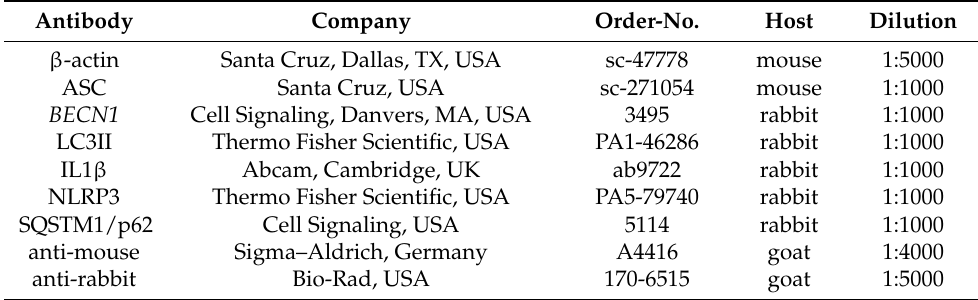
Table 2. List of antibodies used for Western